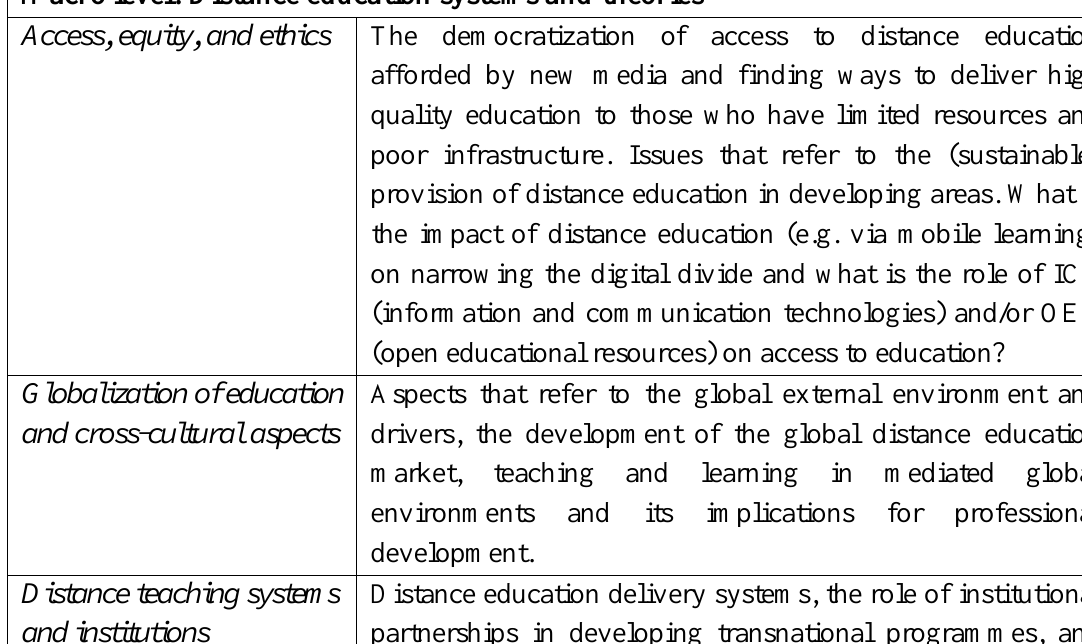
Classification of Research Areas in Distance